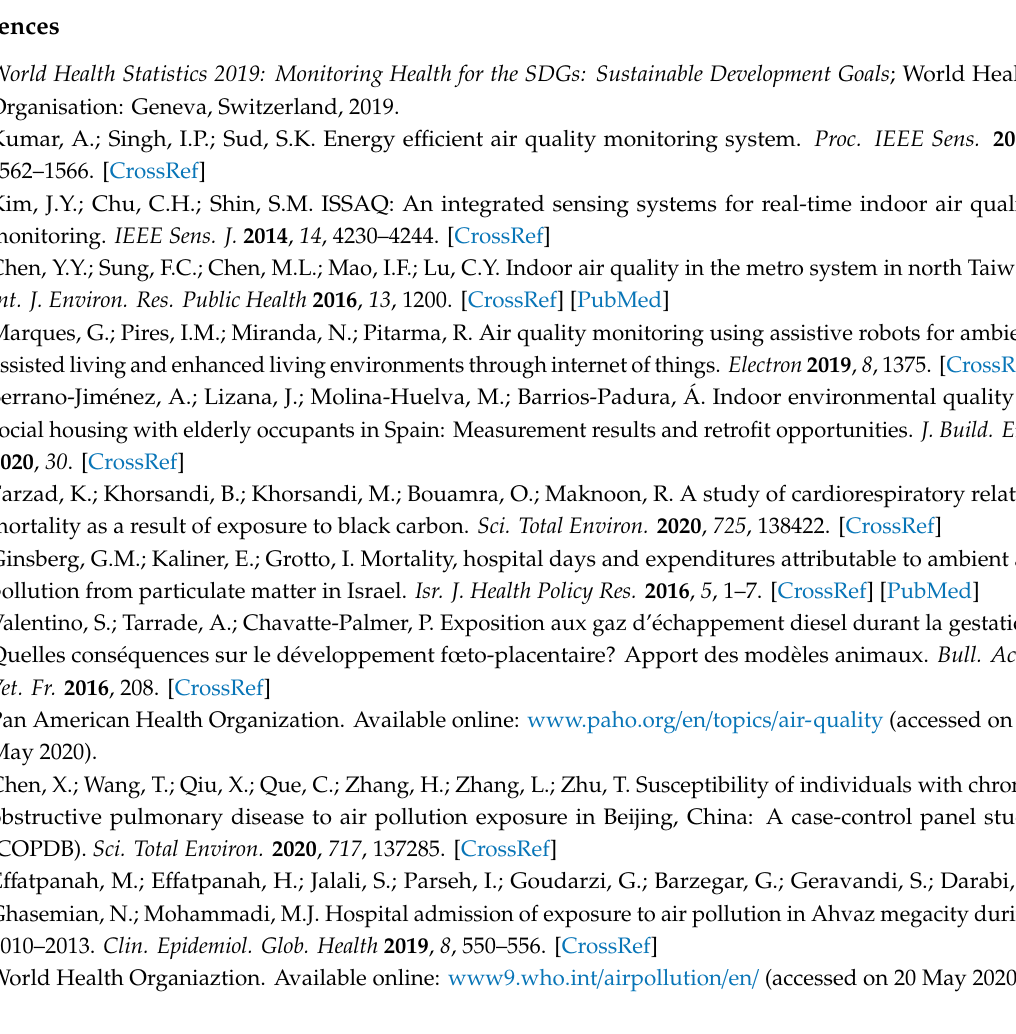
Figure S1: Yearly number of publications related to (a) IoT, (b) IoT for air quality monitoring, (c) IoT using LoRa as wireless technology and (d) air quality monitoring; Figure S2: Coated alumina substrate; Figure S3: Graphene sensor response for NO 2 and CO; Figure S4: Graphic interface of the web service for monitoring sensor data; Figure S5: Graphene sensor response during about 1 day of exposure to background level of NO 2 present in ambient atmosphere, and NO 2 concentration registered by 3 automatic air quality stations in Tarragona; Figure S6: Graphene sensor resistance baseline recovery process performed using temperature pulses; Figure S7: Calibration curve for the graphene sensor response at room temperature; Figure S8: Graphene sensor response during 36 h of exposure to background level of NO 2 present in ambient atmosphere (upper panel) and NO 2 concentration registered by four automatic air quality stations in the Tarragona